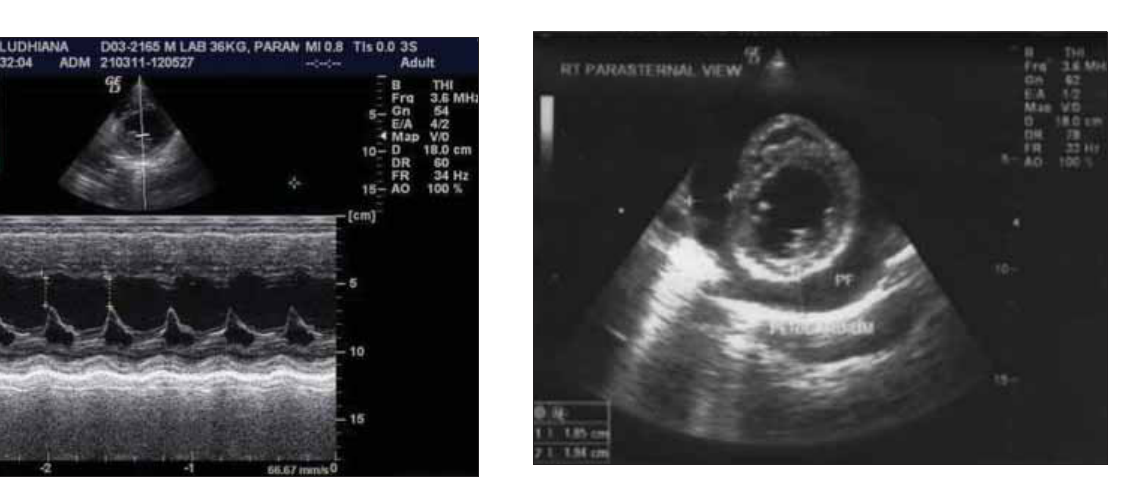
Figure-3: Decreased fractional shortening (FS%) of the animal Affected with